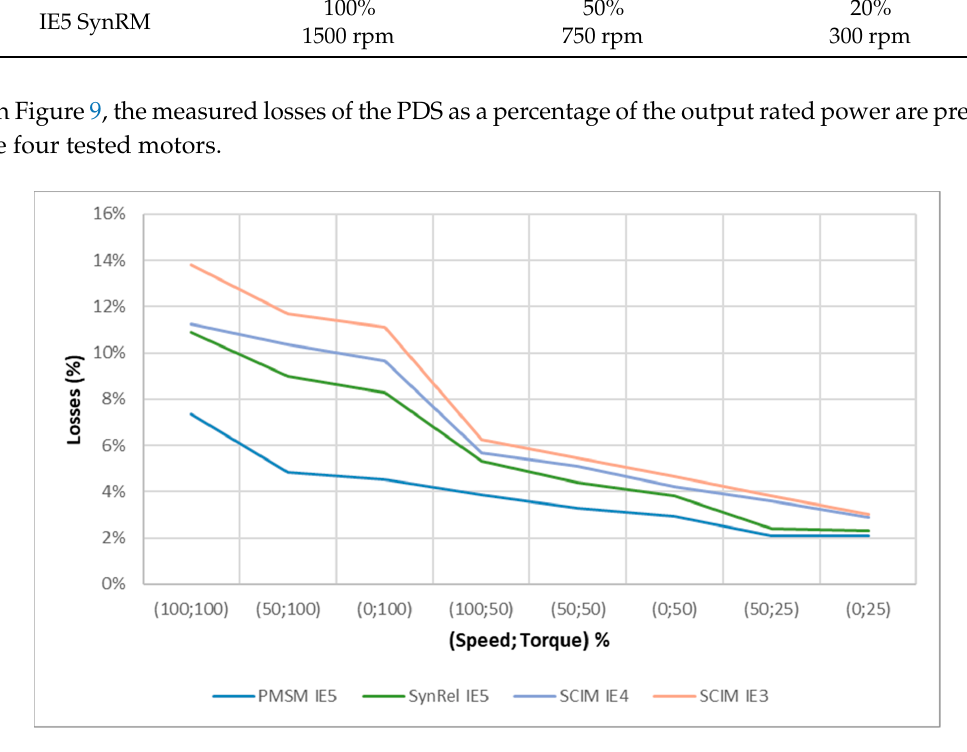
Table 2. Considered motor speed for the eight load points.